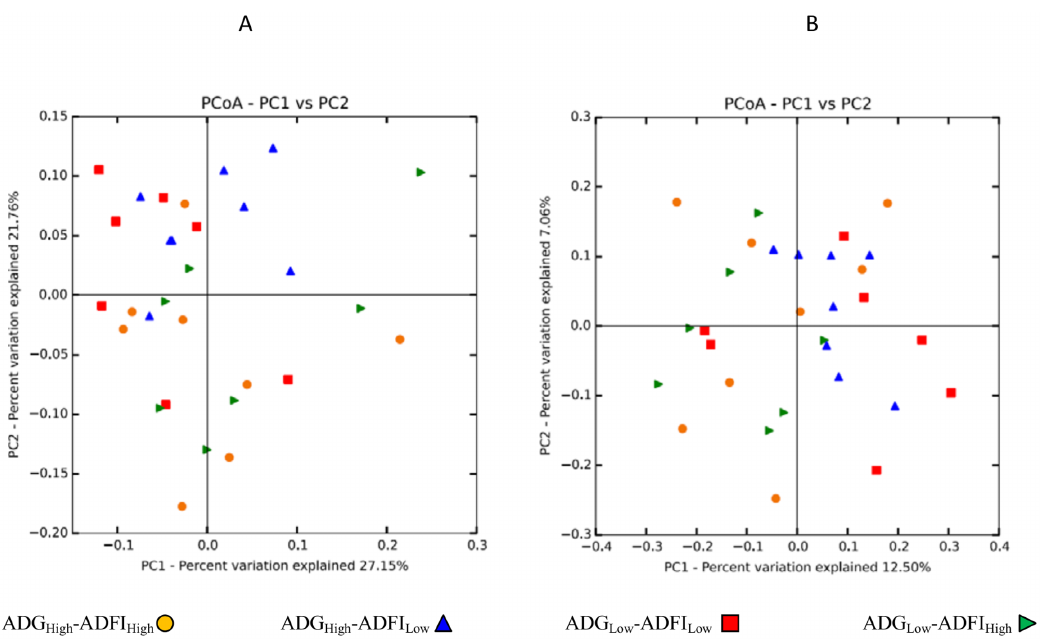
Fig 2. UniFrac principal coordinates analysis (PCoA) displaying correlations among the bacterial communities of the 4 groups. A) Weighted PCoA analyzed from rarefied subsets of 25,000 sequences from each sample. B) Unweighted PCoA analyzed from rarefied subsets of 25,000 sequences from each sample. n = 8, represented by differing